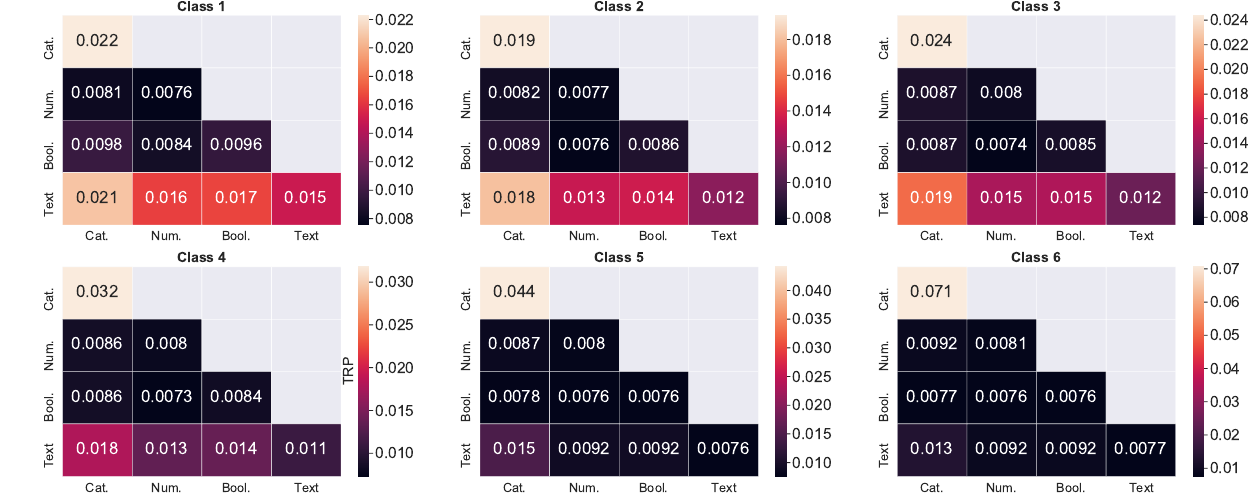
Figure 4. Heatmaps of the attention weights for each class’s final layer in the multihead attention layer. Each row represents one modal from the input information sequence X (cid:48) . Each column in a row represents the attention weight assigned to the specific modal. (Note: To better compare the attention weights across different classes, we removed the softmax activation function while extracting the attention weights from the multihead attention layers.)